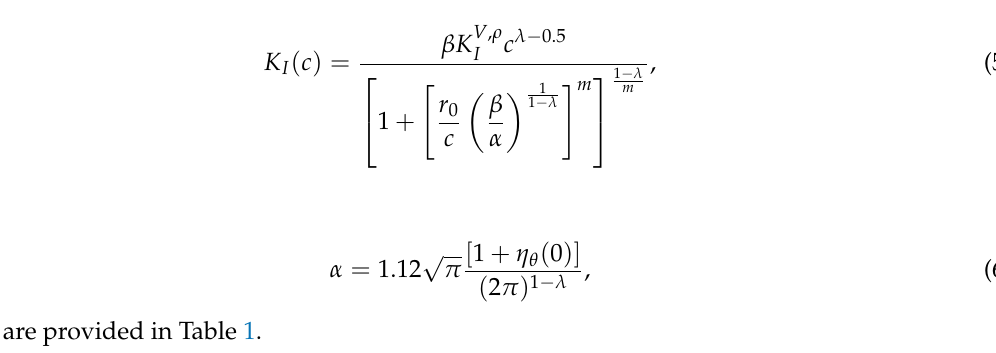
Table 1. Dimensionless parameters used in the present analysis as a function of the notch amplitude ω . See [37] as reference. ω (deg) m λ µ η θ (0) β 0 1.82 0.5000